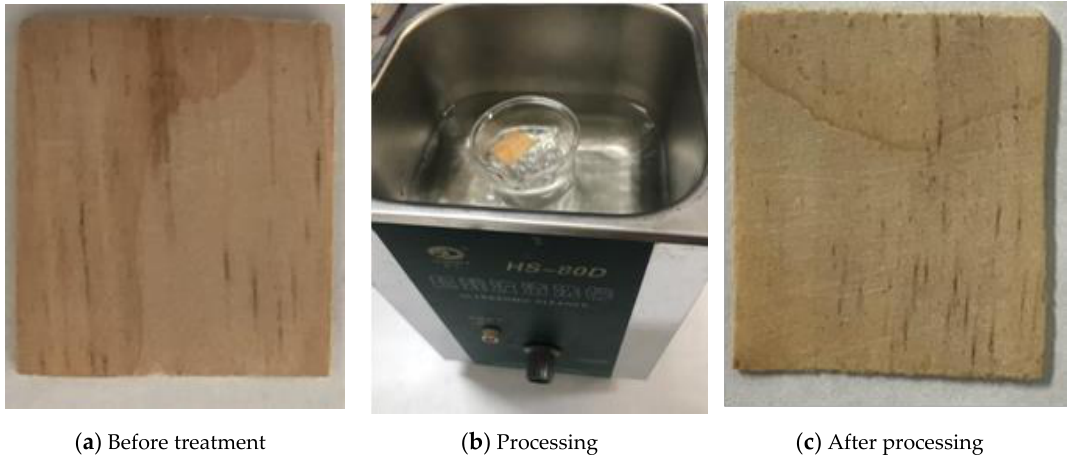
Figure 1. Ultrasonic pretreatment of wood veneer.